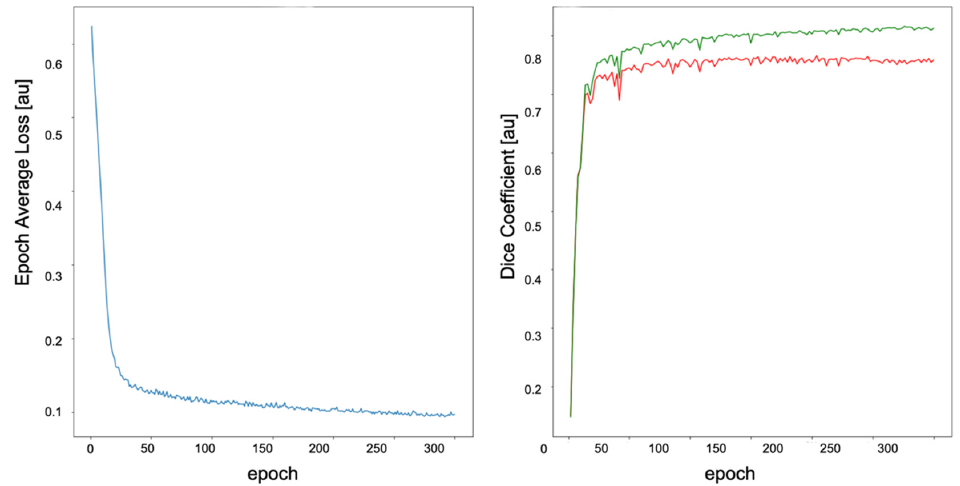
Figure 3. Model training process. Left : Training loss function. Right : DC plot for training (green curve) and validation (red curve) datasets. The DC and average loss values are both arbitrary units. The curves reach a plateau at epoch 100. The model at the epoch 297 was selected as the highest DC (0.84) of the training process. The unit (au) means arbitrary unit.